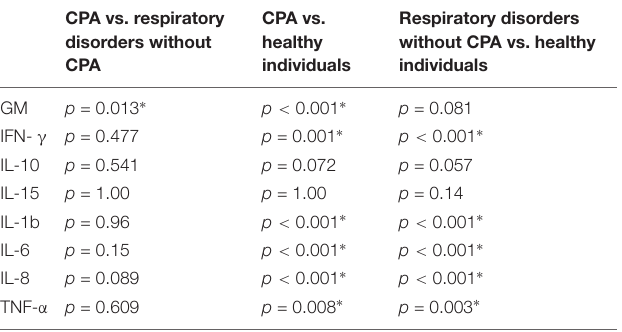
TABLE 3 | P- values of pairwise Wilcoxon rank sum test for GM and cytokines. CPA vs. respiratory CPA vs. Respiratory disorders disorders without healthy without CPA vs. healthy